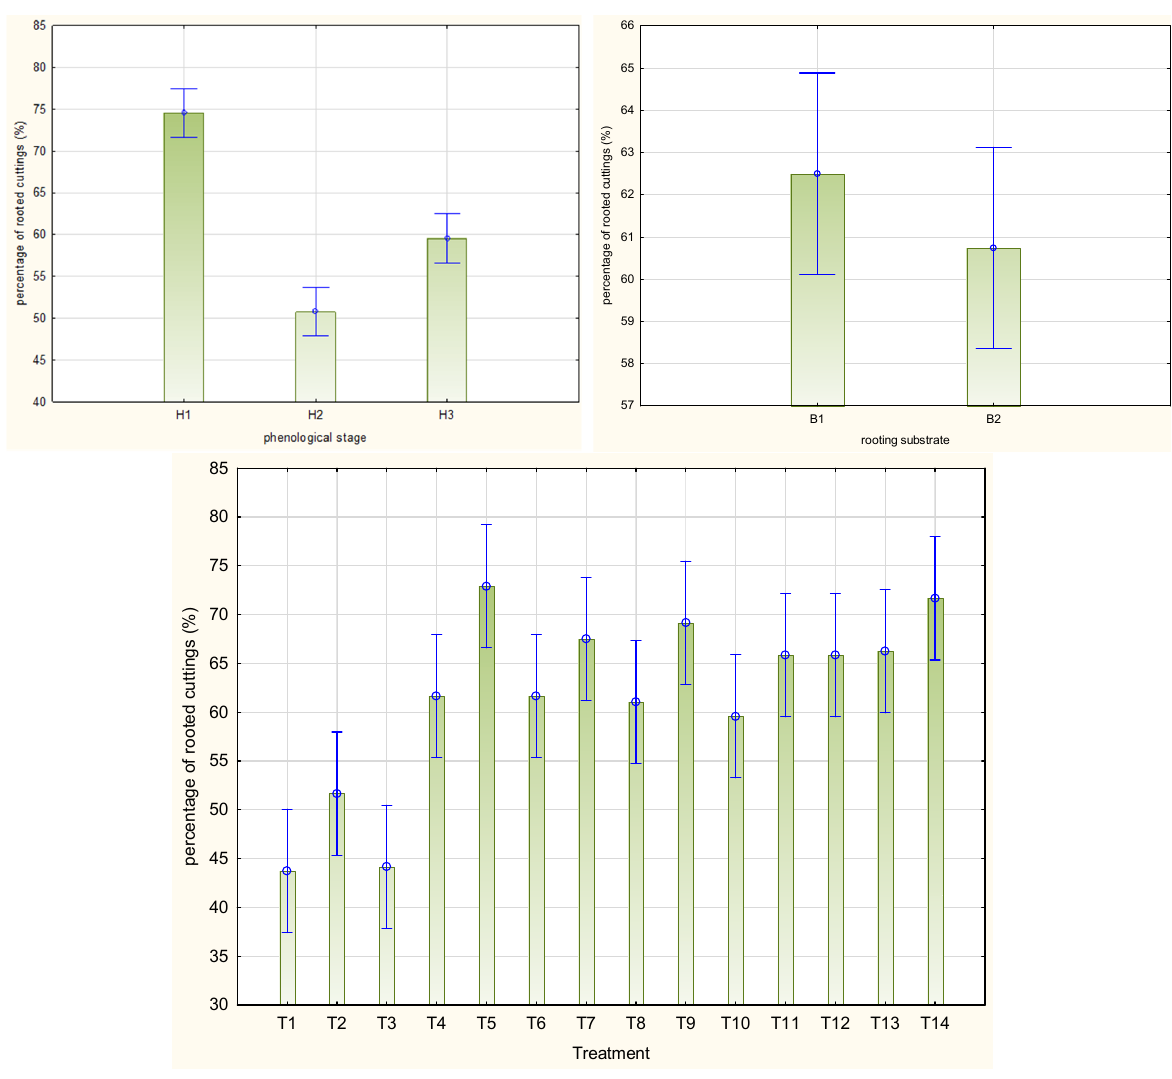
Figure 2. Rooting percentage in Rosa ‘Hurdal’ cuttings prepared from three phenological stages (H1–H3) of shoots and rooted in two rooting substrates after treatment by rooting enhancers. B1—peat–perlite; B2—peat–sand; H1—flower buds closed (BBCH 54,504; flower buds still closed); H2—flowers opened (69,605; full flowering, at least 50% of flowers open); H3—immediately after petal shedding (69,629; end of flowering of second order stem: all petals fallen); and treated: T1—the control cuttings; T2—0.4% IBA (Ukorzeniacz A aqua ); T3—0.2% NAA (Ukorzeniacz B aqua ); T4, T5, T6, T7, T8, T9—Algae Extract: watering with 0.4% or 0.6% Bio Rhizotonic (10 mL) 1, 2, or 3 times (after planting and 10 and 20 days later); T10, T11, T12—Organic Preparation—watering with 0.1%, 0.2%, or 0.4% Root Juice™ (10 mL) after planting; T13, T14—Plant Extract—watering with 0.012% or 0.02% Bio Roots (10 mL) after planting. Vertical bars denote 95% confidence intervals for the mean of counts (one-way ANOVA).